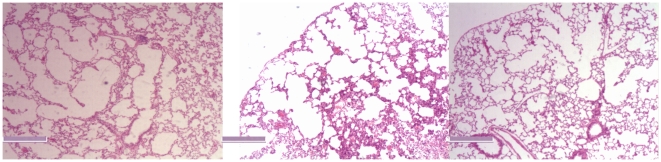
Pathologic pictures were obtained from emphysematous rats, stained with hematoxylin/eosin (H/E), and captured with 40 X light microscopy.Scale at left lower represents the length of 1000 µm.